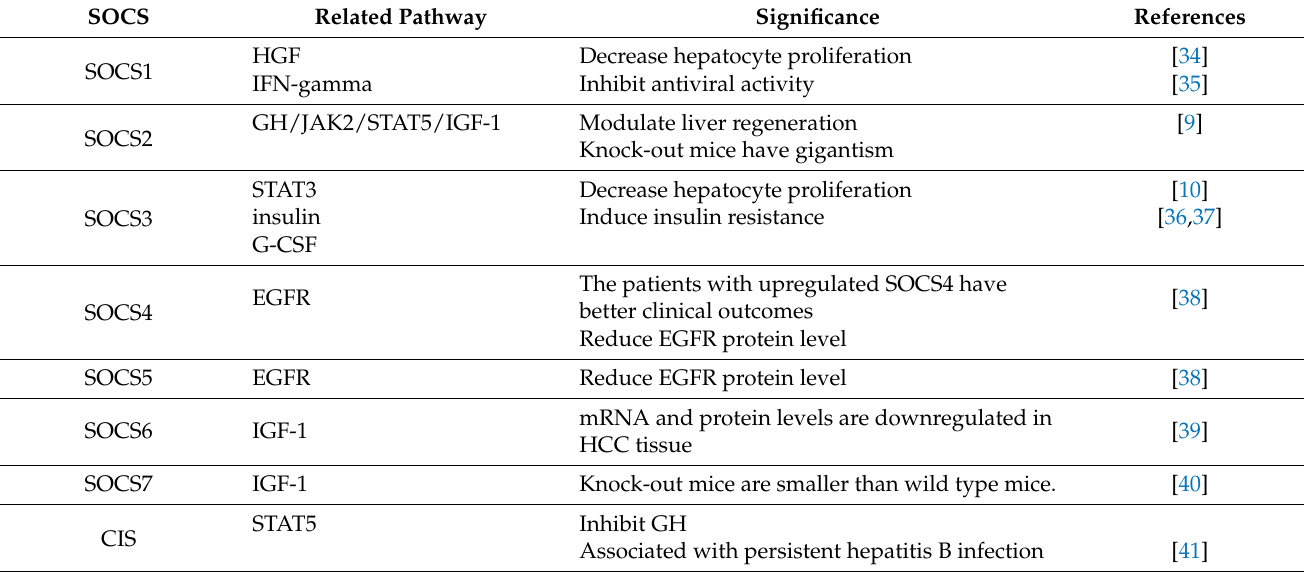
Table 1. A summary of the SOCS family in liver